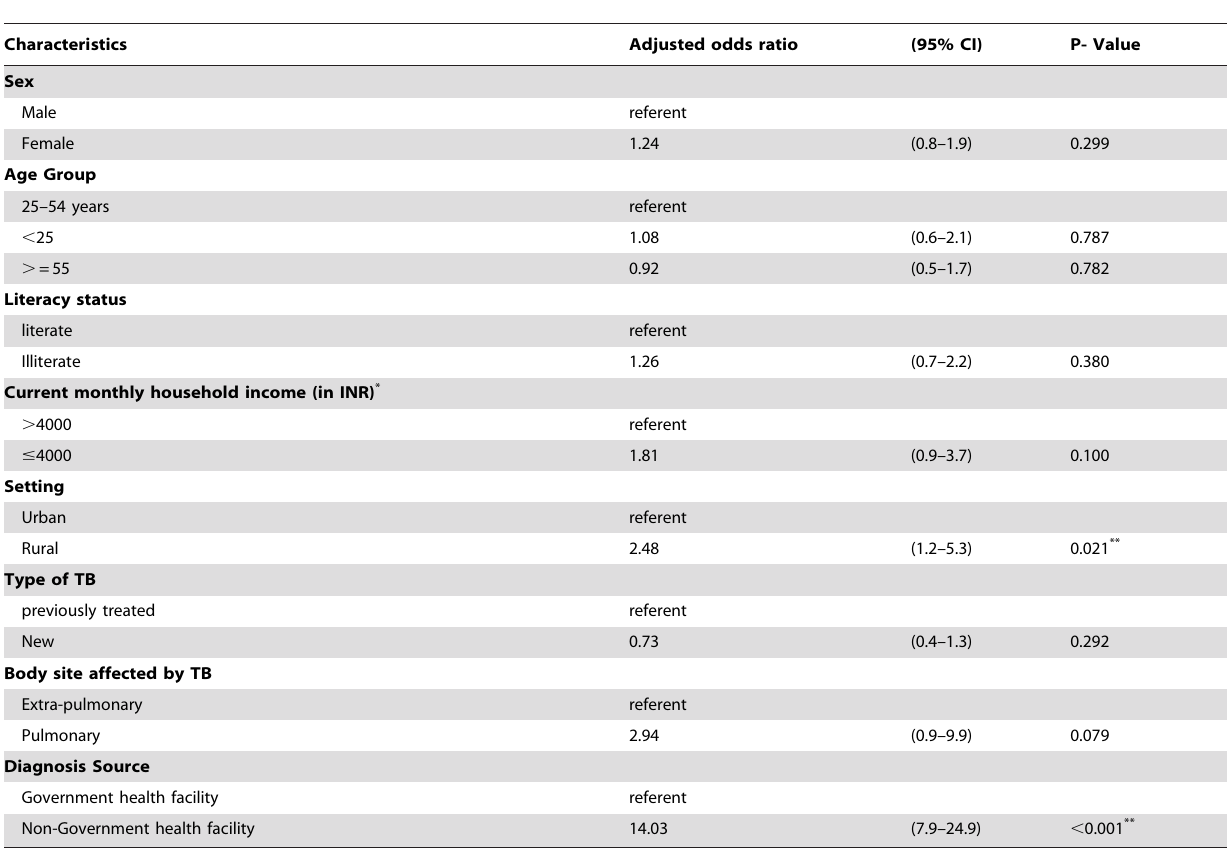
Table 4. Multivariate analysis for characteristics associated with patients accessing TB treatment ‘outside DOTS/RNTCP’ in a community based survey, India, 2011 (N